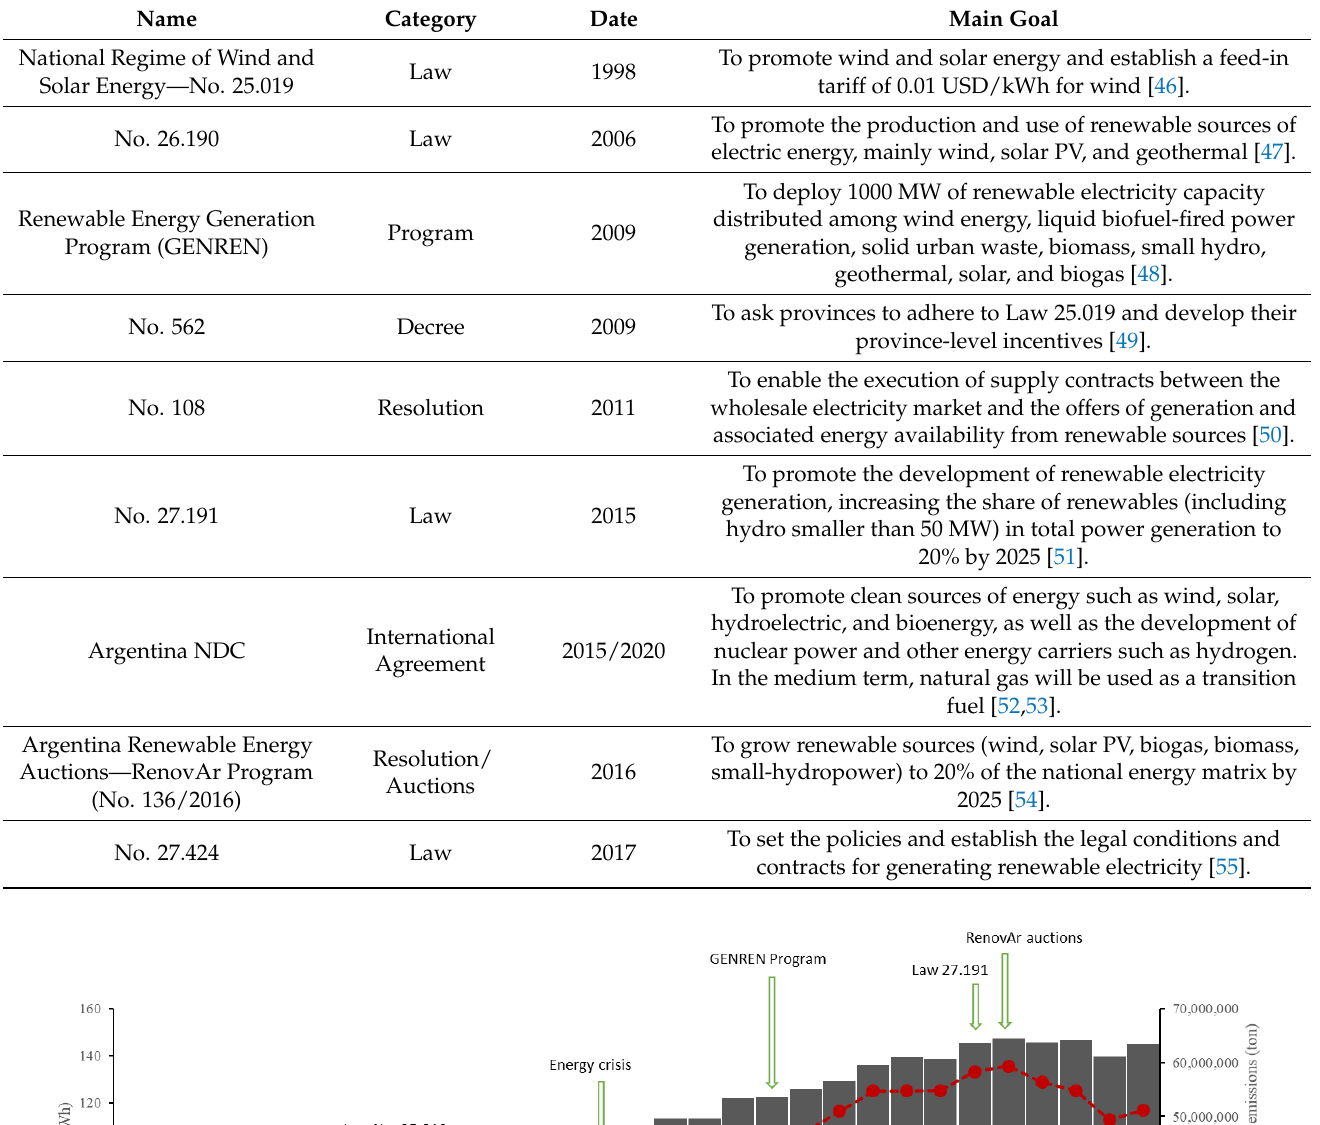
Table 2. Main government incentives for the entry of renewable energy into Argentina’s electric- ity sector.